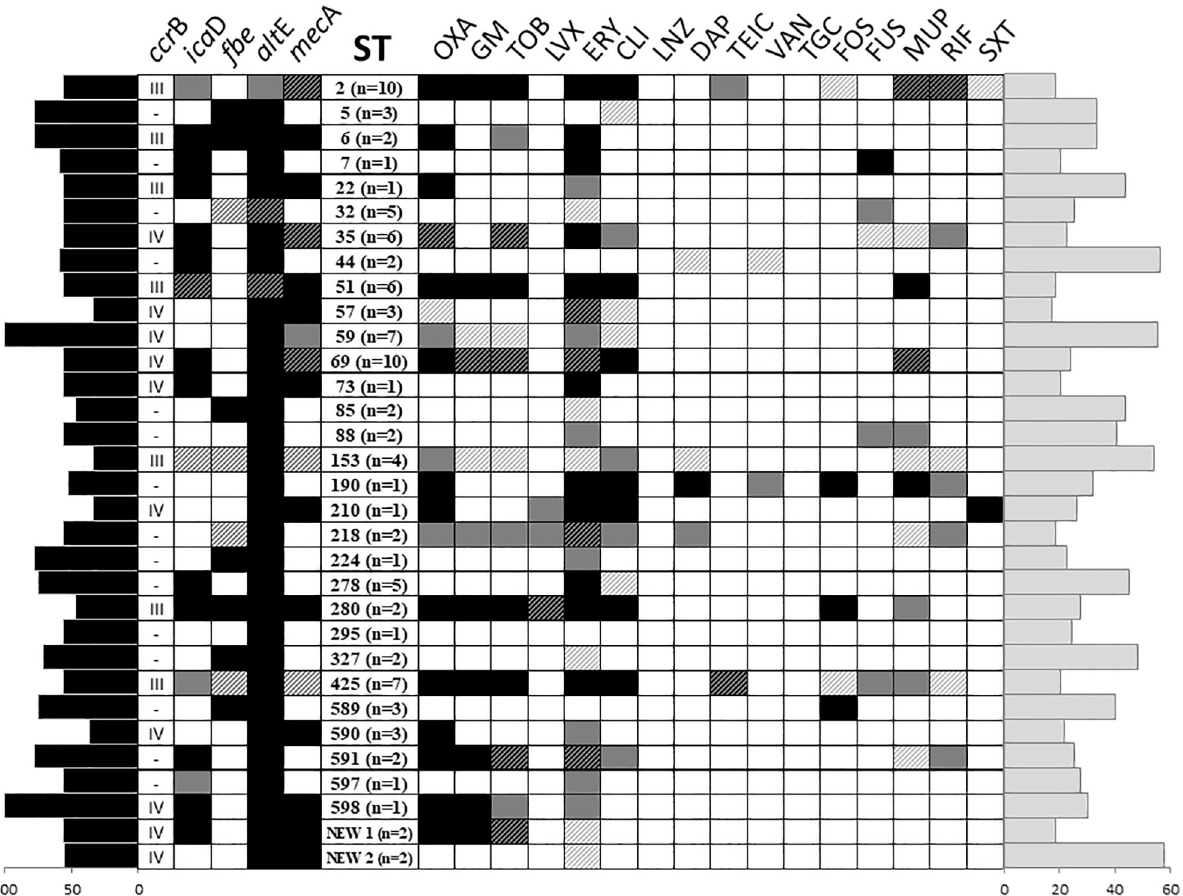
Fig 3. Profiles of antibiotic susceptibility and virulence factors in the different ST clones. At least one different sequence types (ST) per infant is represented in each line. Results are represented in function of frequency. Black squares means 100% of the isolates were resistant to an antibiotic or present a virulence determinant, while black and grey striped boxes means 75–99%, grey squares 50–74%, grey and white striped squares 25–49% and white boxes 0–24%. Black bars in the left side of the figure represent the percentage of virulence genes present in each ST while the grey bars on the right side of the figure shows the percentage of antibiotic resistances per ST. OXA: Oxacillin; GM: Gentamicin; TOB: Tobramycin; LVX: Levofloxacin; ERY: Erythromycin; CLI: Clindamycin; LNZ: Linezolid; DAP: Daptomycin; TEIC: Teicoplanin; VAN: Vancomycin; TGC: Tigecycline; FOS: Fosfomycin; FUS: Fusidic Acid; MUP: Mupirocin; RIF: Rifampicin; SXT: Trimethoprim-sulphamethoxazole. https://doi.org/10.1371/journal.pone.0227823.g003 PLOS ONE | https://doi.org/10.1371/journal.pone.0227823 February 3,